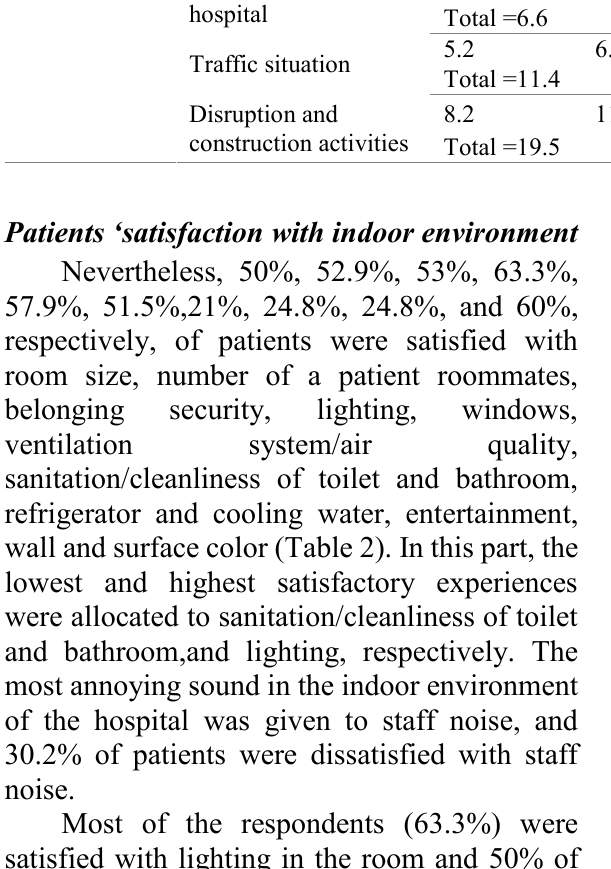
Satisfaction from outdoor view